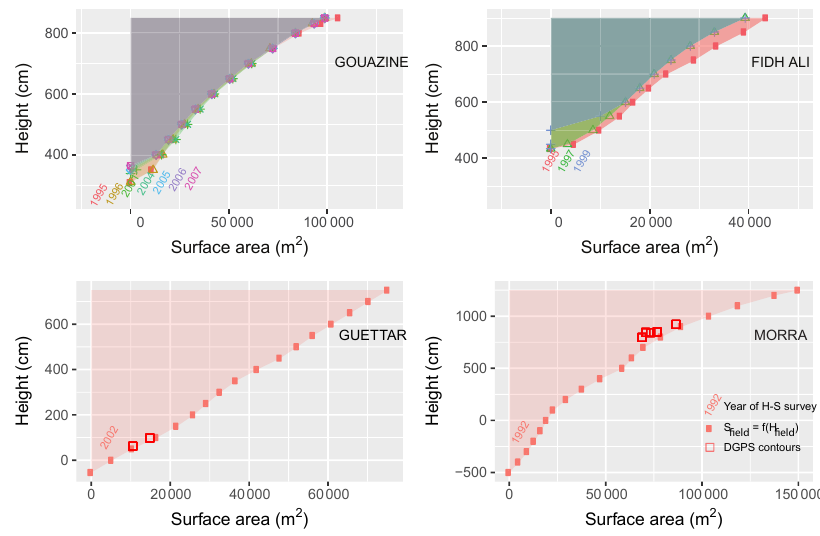
Figure 3. Evolution over time of stage height–surface area rating curves for four lakes.